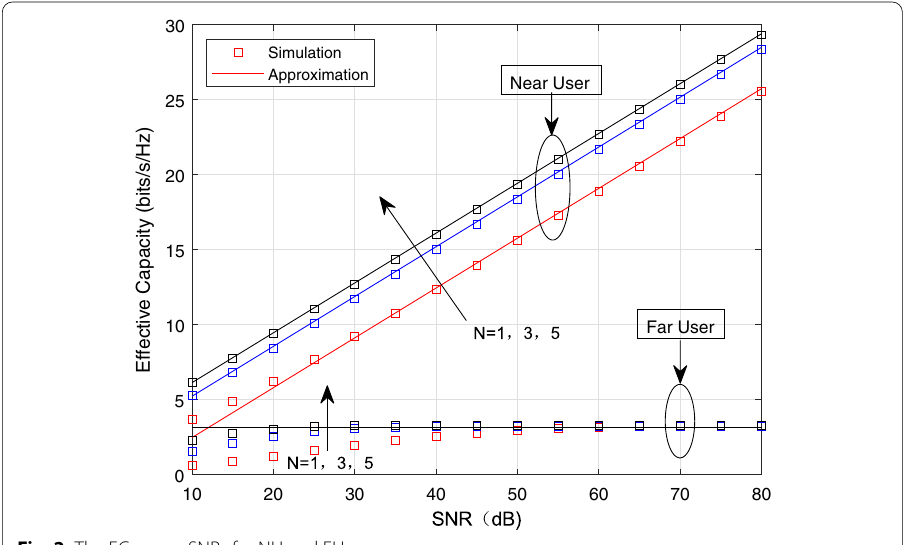
Fig. 2 The EC versus SNRs for NU and